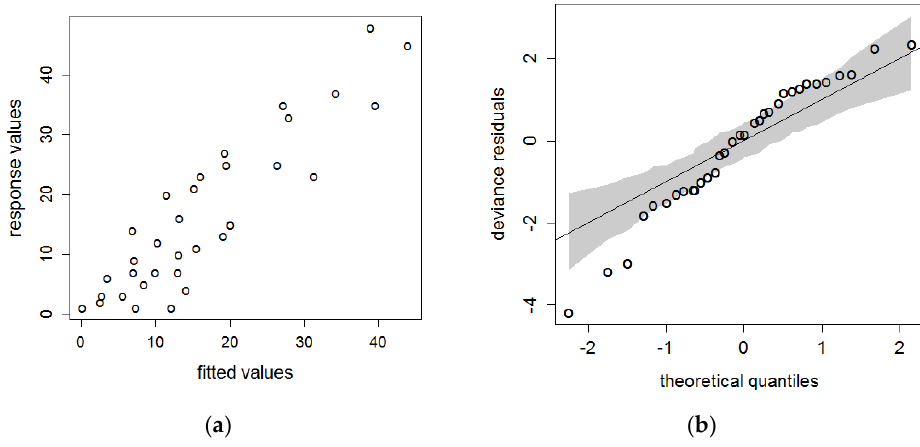
Figure 3. Fitted against response values of Quercus macdougallii smooth function ( a ), and distribution of its residuals in a Q ‐ Q plot, showing a 99% confidence interval ( b ).